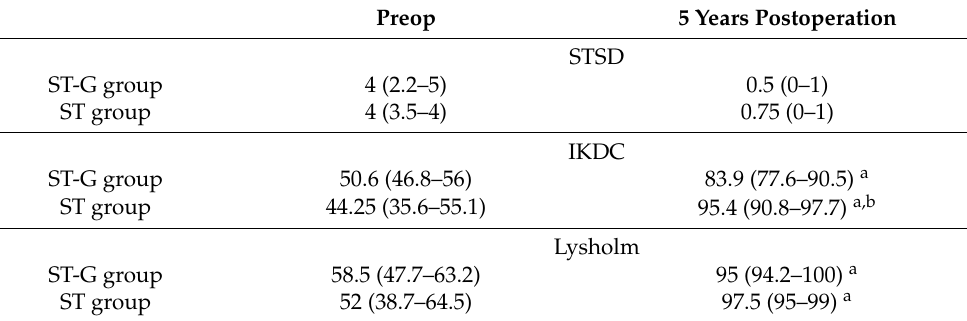
Table 2. Results of the two groups of patients (median and 25–75% interquartile range). STSD—Side-to- side anterior tibial translation differences (injured vs. uninjured knee) in mm; Preop—Preoperatively; ST—semitendinosus; ST-G—semitendinosus and gracilis. a p < 0.001 when comparing the preoperative and 5-year postoperative groups; b p < 0.001 when comparing the ST and ST-G groups.